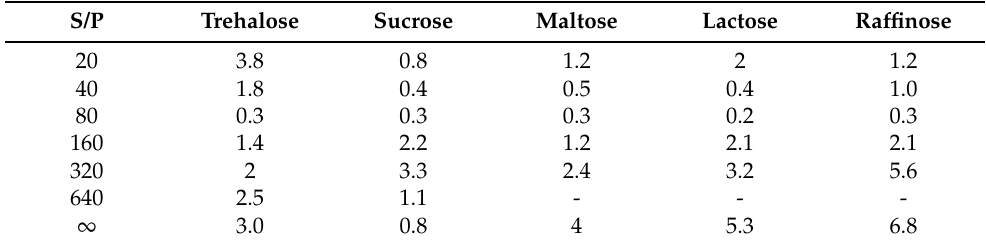
Table 1. Water/Saccharide molar ratio (W/S). Data are taken from [37]. S/P